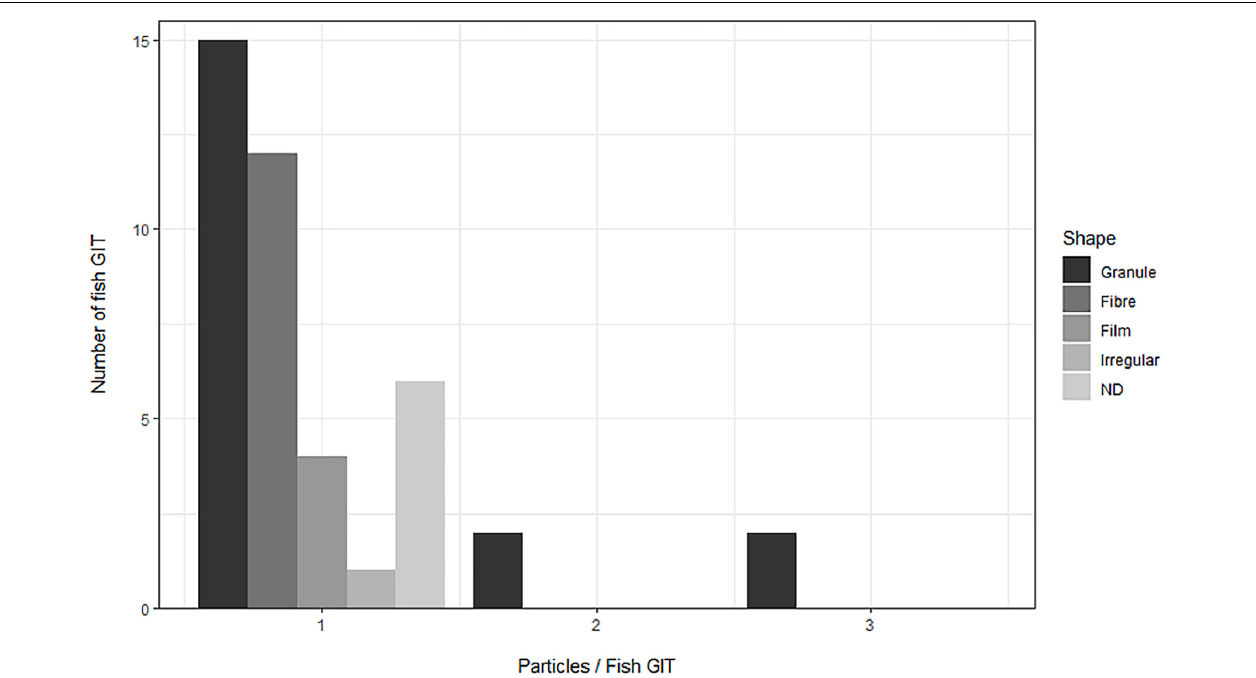
FIGURE 7 | Number of samples (fish GIT) where one, two, or three particles per sample were observed, per particle shape (fibres, films, granules, or of irregular shape). Observations done in scenario i (Nile red observations). ND, not determined.